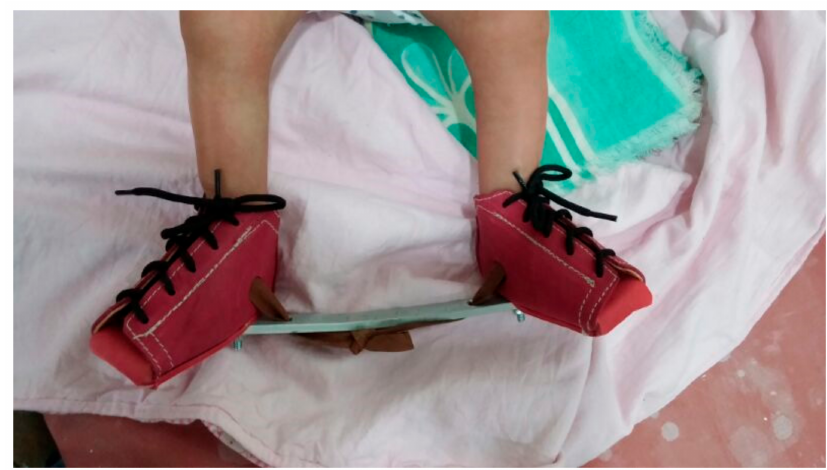
Figure 7. Dennis Brown (DB) splint and shoes.